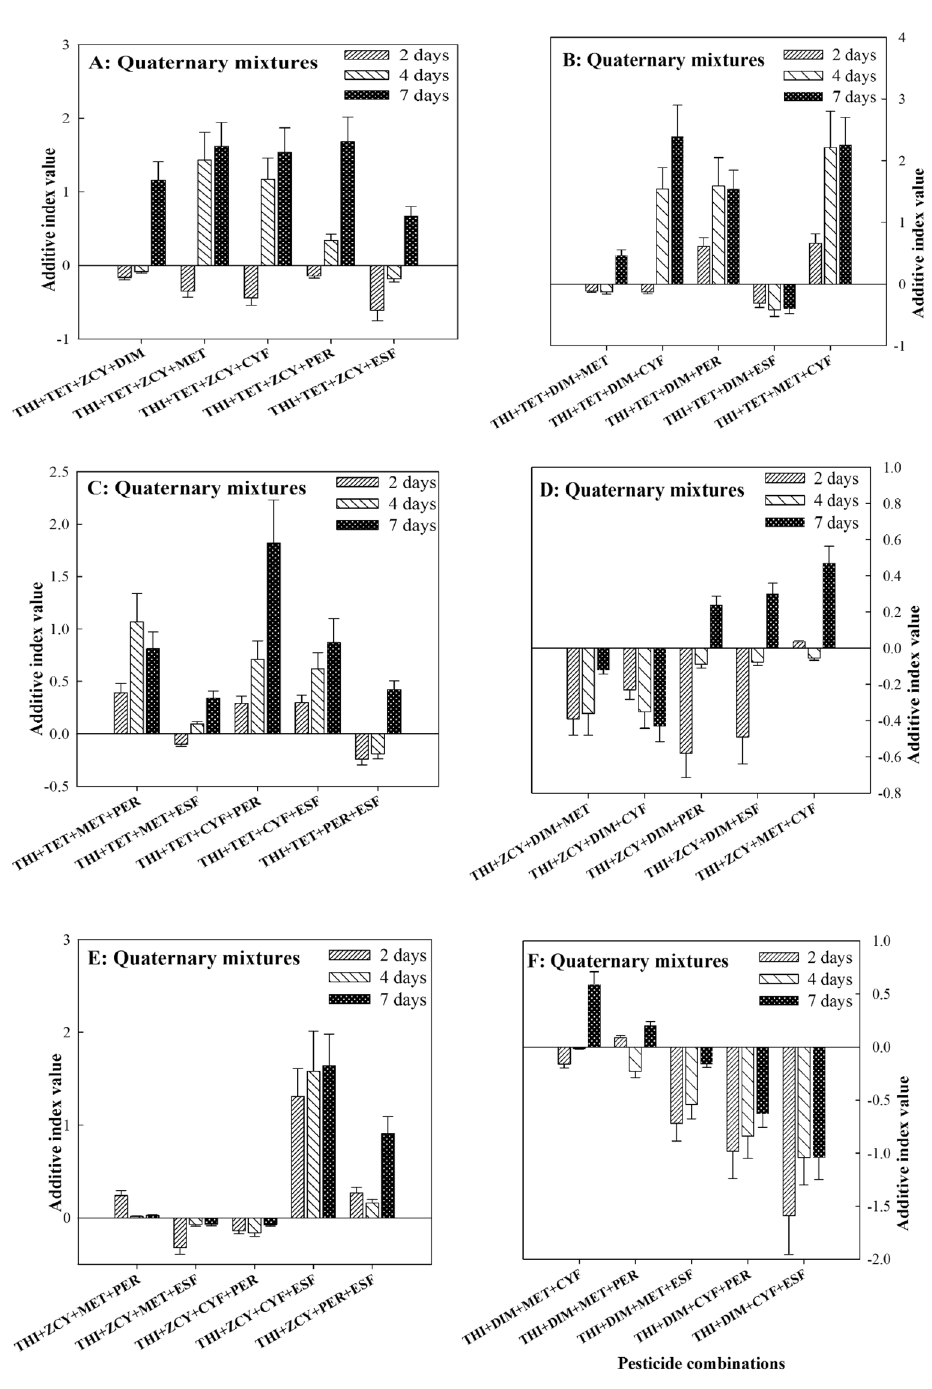
Figure 2. Joint toxic effects of quaternary combinations of thiamethoxam (THI) mixed with seven pesticides on honey bees. CI confidence interval, THI Thiamethoxam, TET Tetraconazole, ZCY Zeta -cypermethrin, DIM Dimethoate, MET Methomyl, CYF Cyfluthrin, PER Permethrin, ESF